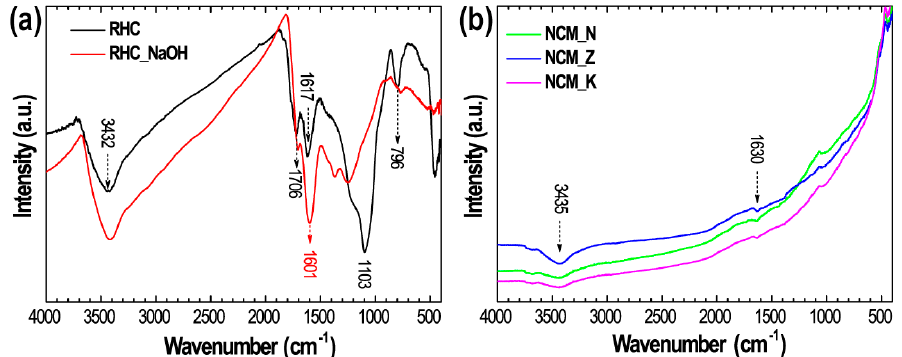
Figure 1. ( a ) FT-IR spectra of RHC and RHC_NaOH, and ( b ) FT-IR spectra of NCM_N, NCM_Z, and NCM_K recorded at 25 °C.